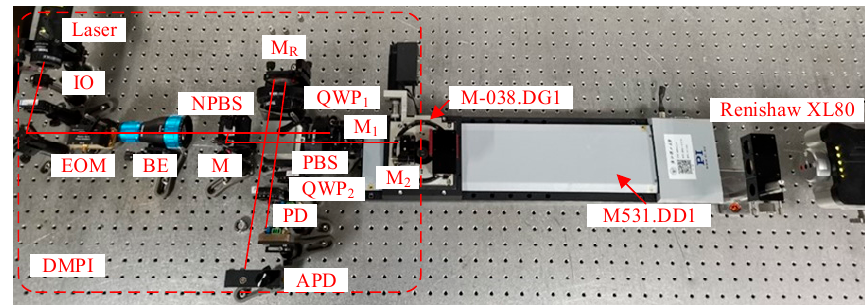
Figure 3. Constructed experimental setup.